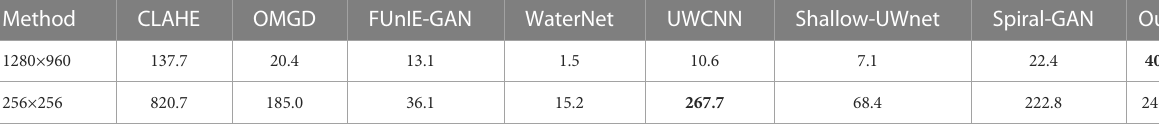
TABLE 4 Frames per second (FPS) of different methods on the underwater video.